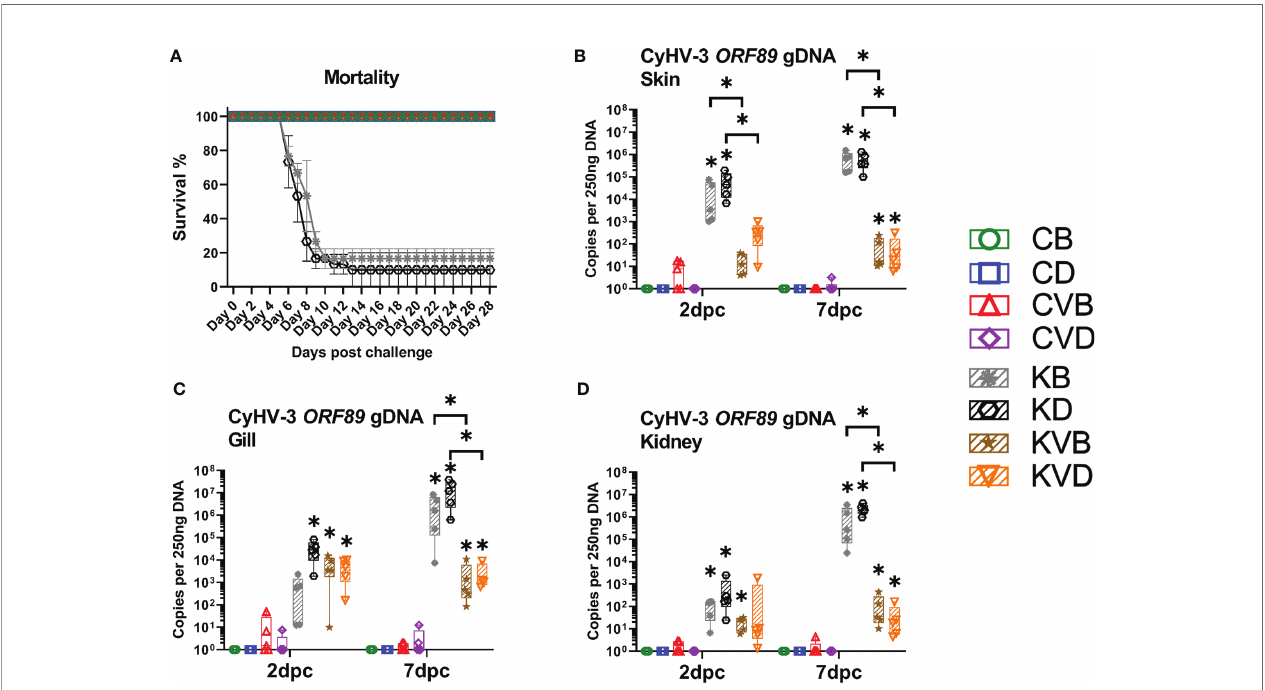
FIGURE 4 | Mortality and virus load during the challenge with CyHV-3. (A) Approximated mortality during challenge. (B) Virus load in the skin collected 2 dpc and 7 dpc. (C) Virus load in the gills. (D) Virus load in the kidney. The description of experimental groups: CB – BSA, non-vaccinated, unchallenged control, CD – defensins, non-vaccinated, unchallenged control, CVB – BSA, vaccinated, unchallenged control, CVD – defensins, vaccinated, unchallenged control, KB - BSA non- vaccinated, CyHV-3 challenged, KD – defensins non-vaccinated, CyHV-3 challenged, KVB – BSA, vaccinated, CyHV-3 challenged, KVD – defensins, vaccinated, CyHV-3 challenged. The results are presented as 25%-75% box plots with min. and max. values as whiskers with indication of all data points. The data are shown as the virus genome copy numbers per 250 ng of extracted DNA. * indicates statistical signi fi cant difference at p < 0.05. Statistical analysis was performed with two- way ANOVA with multiple comparisons test performed with the Holm-Sidak